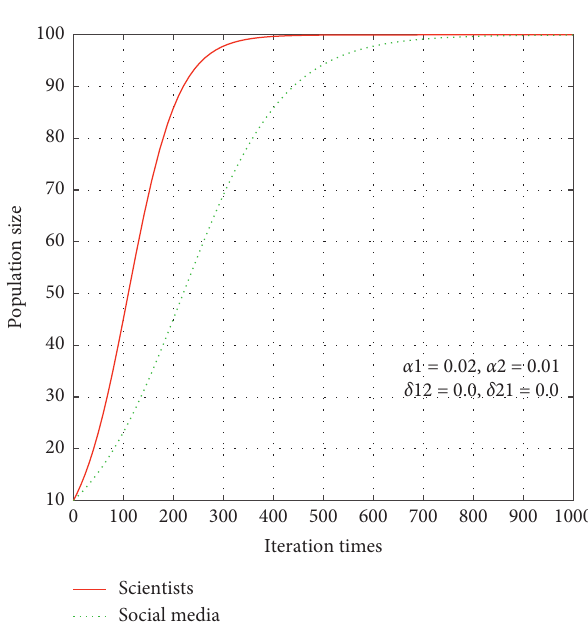
Figure 3: Independent coexistence pattern. Changes in the size of the two populations after 1000 iterations ( α � 0, and δ � δ 12 21